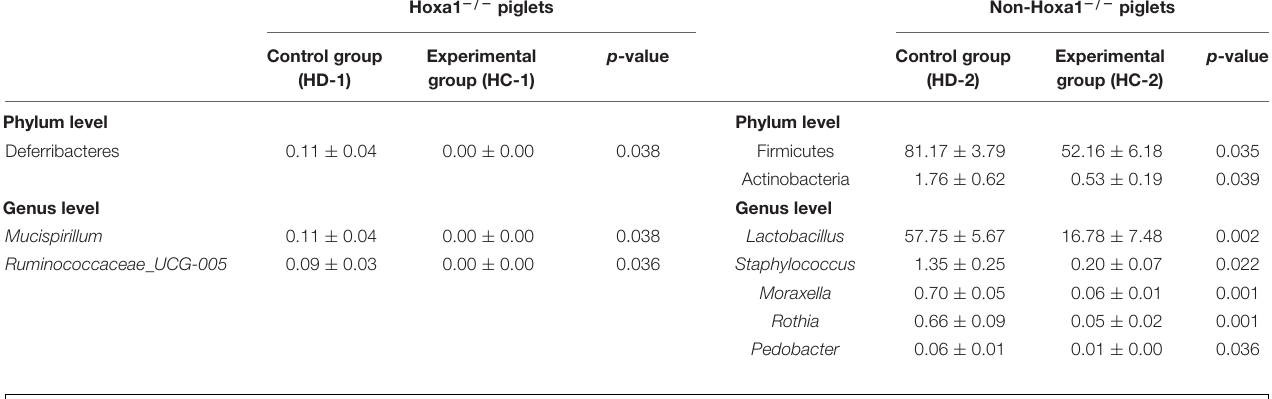
TABLE 6 | The differential ileal bacterial community of newborn piglets with the same genotype between the control and experimental groups (%). Hoxa1 − / − piglets